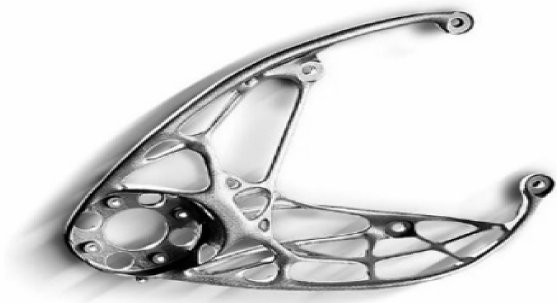
Figure 16. Thales Alenia Space antenna brackets